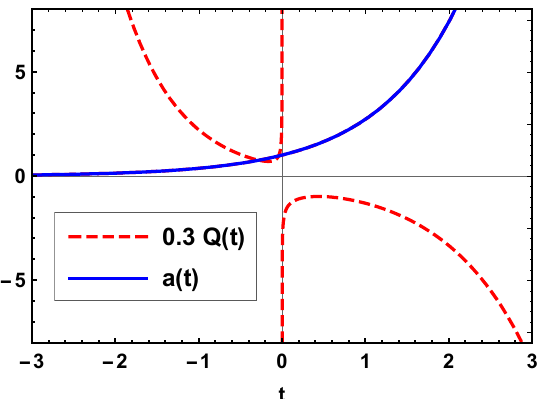
Figure 7. Time evolution of the scale factor (solid line) and the quantum potential (45) (dashed line) for the de Sitter solution, setting k = a 0 = γ =